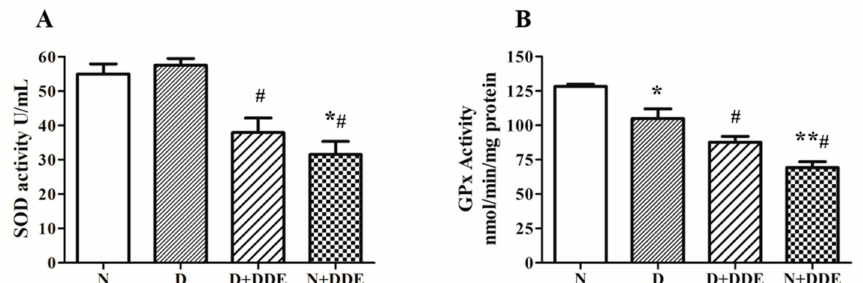
Figure 2. Activity of total superoxide dismutase (SOD) ( A ) and total glutathione peroxidase (GPx) ( B ) levels in testis homogenate. Fold change vs. controls was obtained as mean ± standard deviation for each experimental group. One-way ANOVA analysis showed significant di ff erences between treated and control rats: * p < 0.05 vs. N; ** p < 0.01 vs. N; # p < 0.05 vs. D. Two-way ANOVA analysis for total SOD (A) indicated significant diet e ff ect, extremely significant DDE e ff ect, and no significant interaction. Two-way ANOVA analysis for GPx (B) indicated no significant diet e ff ect, extremely significant DDE e ff ect, and extremely significant interaction (Bonferroni Post-hoc test: p < 0.001 D vs. N, p < 0.01 D + DDE vs. N +